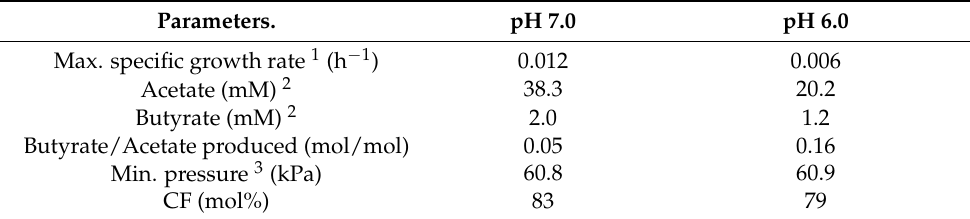
flasks; CF, Carbon fixation determined using Equation (1), from 0–120 h.